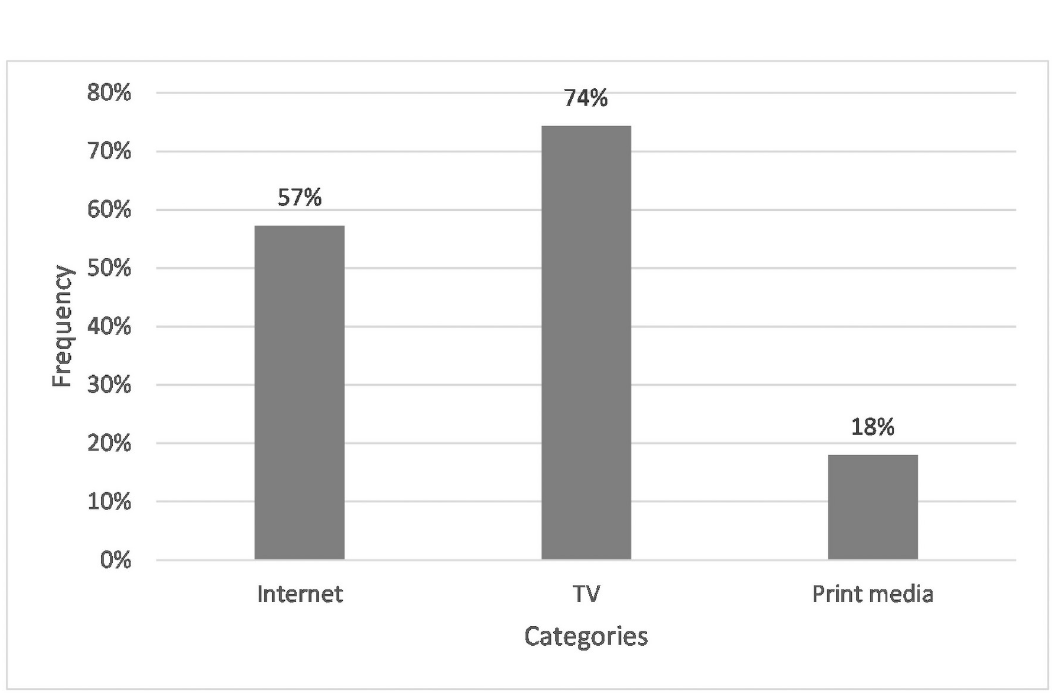
Fig 6. Frequencies of students whose answers specified the term ‘media’in Q2: “Where do you get your knowledge about microplastics from?” n = 117. Open question with categories formed from students’ answers.